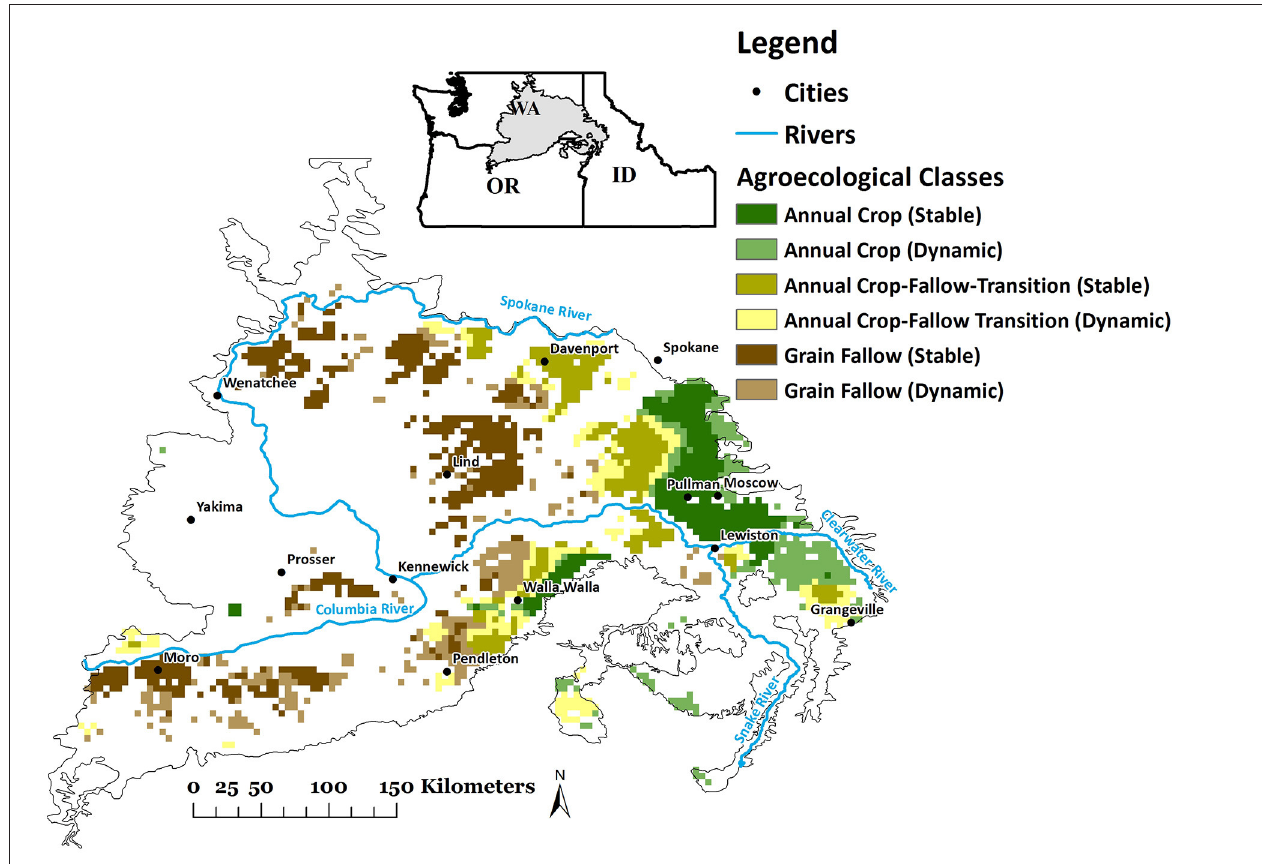
FIGURE 1 | Agro-ecological classes (AECs) for years 2007 through 2014 at 4-km